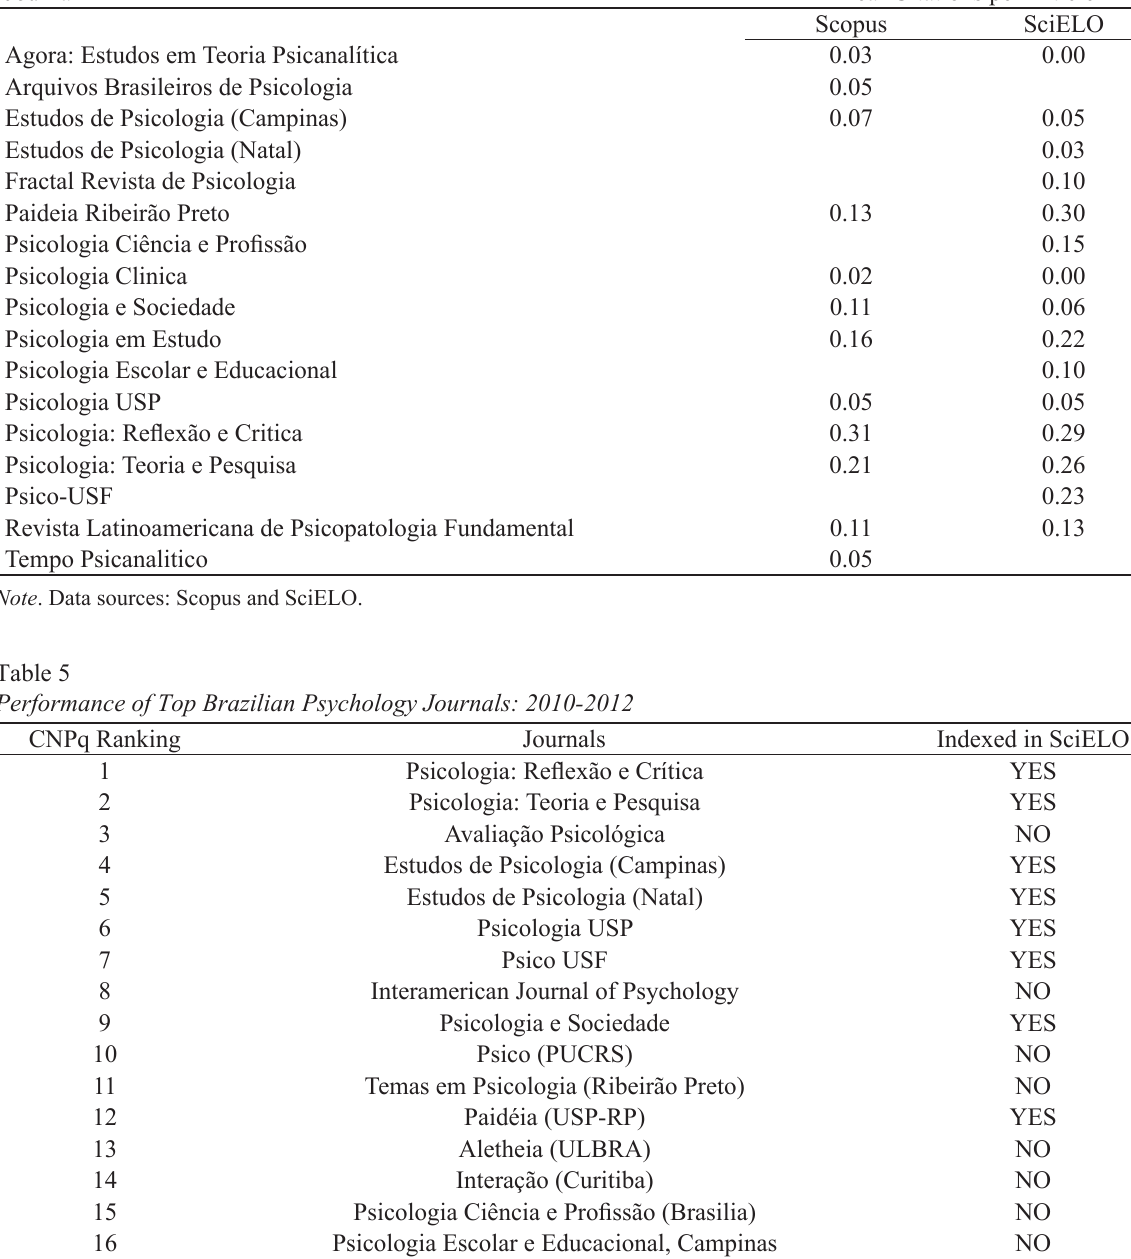
Performance of Brazilian Psychology Journals: Citations per Article in 2012 for Articles Published in 2010 and 2011